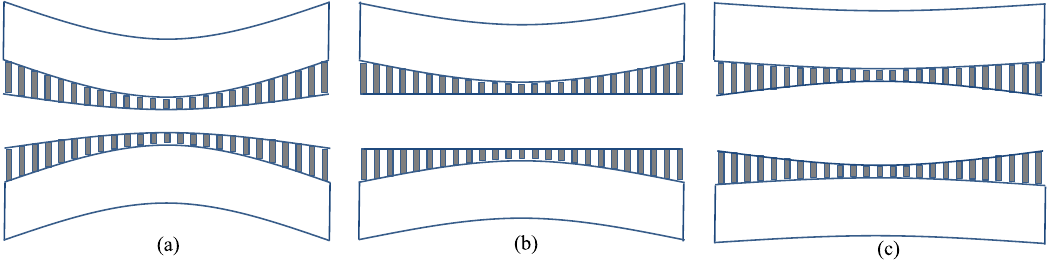
FIG. 4. Girder and pole deformation on the EXFEL undulators with applied pole height tuning. (a) At small gaps Δ g > 0 , concave case; (b) at the tuning gap Δ g ¼ 0 , flat case; (c) at large gaps Δ g < 0 , convex case. The aluminum support girders gradually deform from convex at small gaps to flat at very large